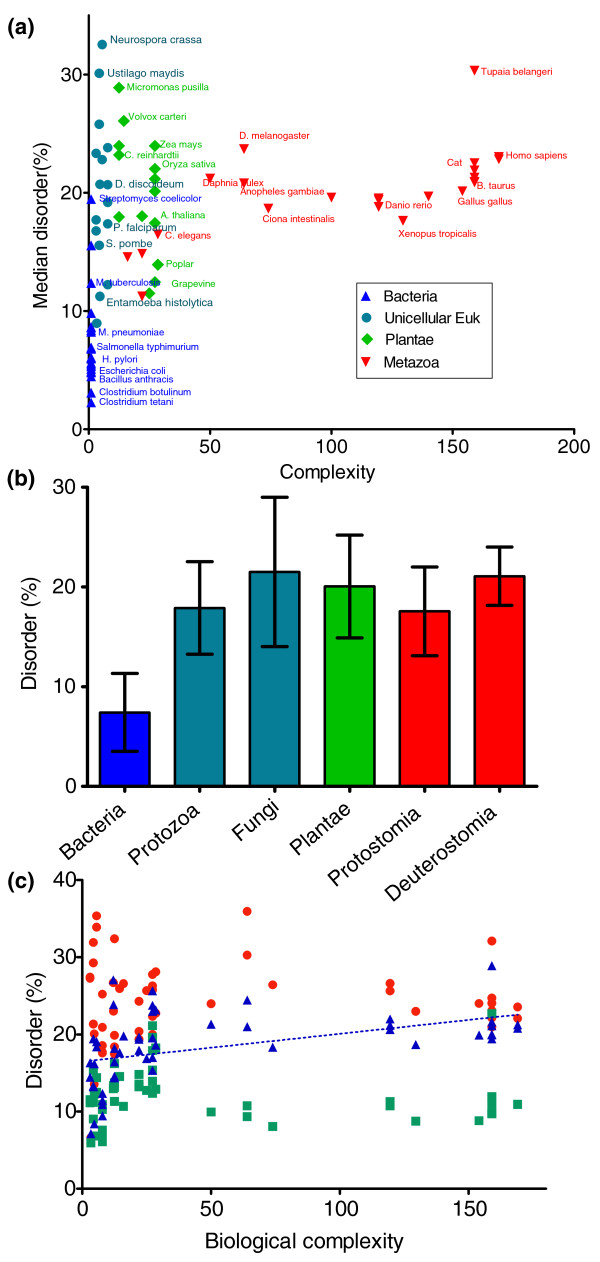
Structural disorder of proteins in prokaryotic and eukaryotic species. (a) Average structural disorder in prokaryotes and eukaryotes was predicted by the IUPred algorithm [25], averaged over all proteins in the proteome, and is shown as a function of biological complexity of the species. (b) Species were grouped into six clusters and average disorder within these groups was calculated (error bars represent standard deviation). (c) Proteins were sorted on the basis of their Structural Classification of Proteins (SCOP) [43] domain expansions and their average disorder is shown as a function of biological complexity of the species. In particular, there are proteins in which domain expansion correlates (red circle) or does not correlate (green square) with biological complexity. For comparison, proteins are also shown that contain any kind of SCOP domain (blue triangle).